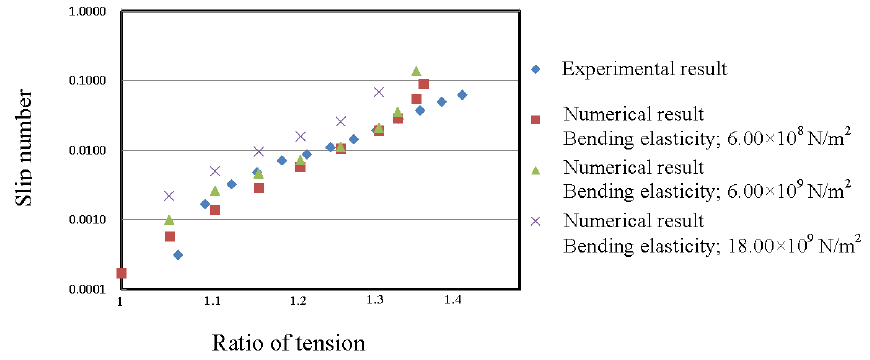
Figure 11. Ratio of tension vs. slip number for various values of the bending elasticity.